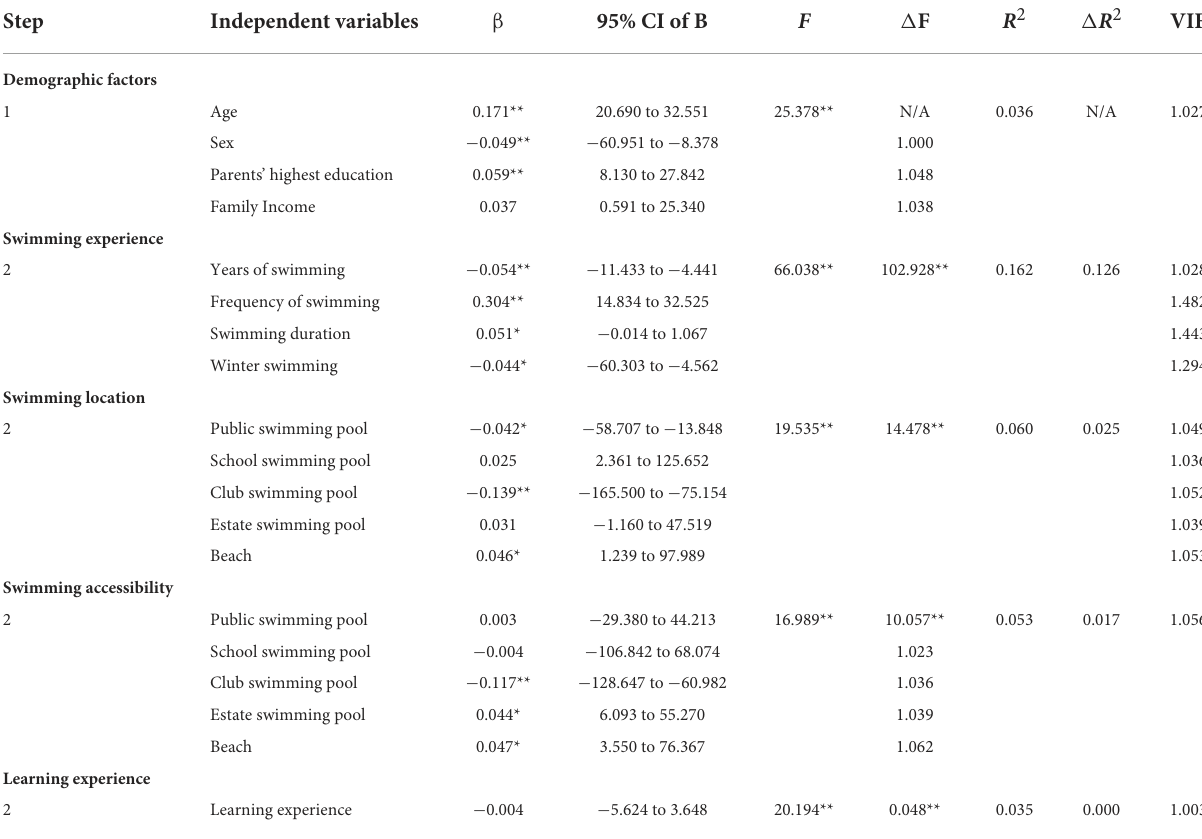
TABLE 4 Results of hierarchical linear multiple regression